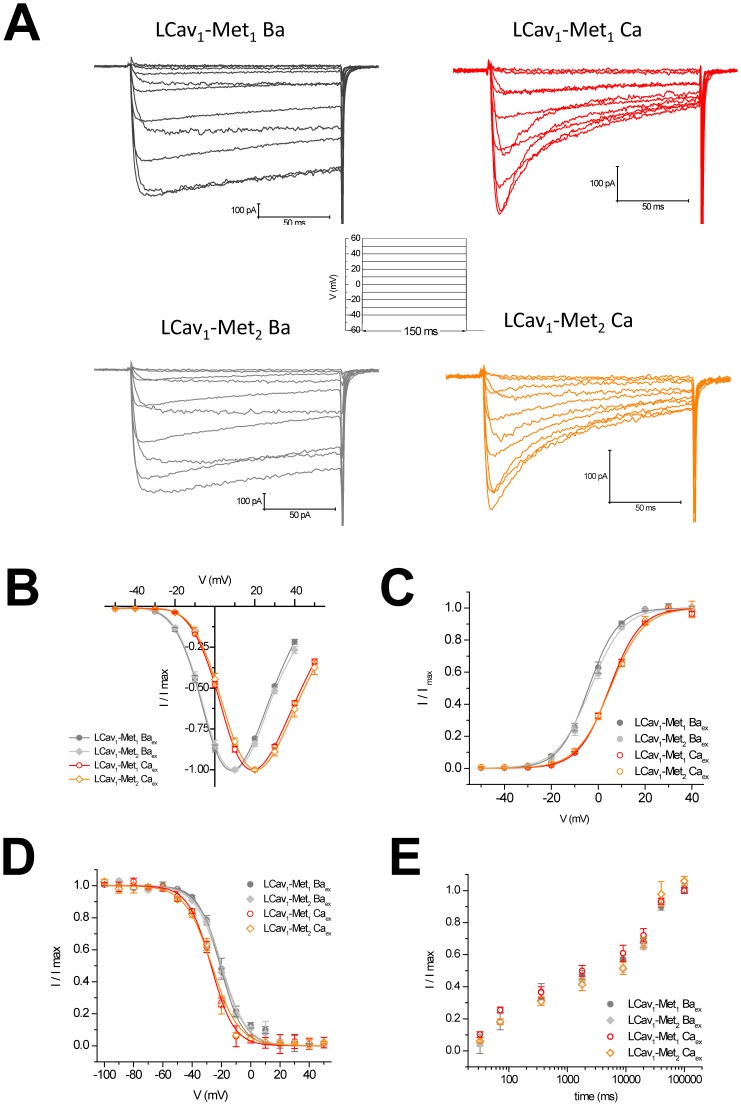
No major differences in biophysical properties between snail LCav1 channel containing a full-length N-terminus with NSCaTE translated from upstream methionine Met1 or truncated N-terminus missing NSCaTE generated from the downstream methionine Met2.LCav1-Met1 and LCav2-Met2 were transfected in HEK-293T cells alongside mammalian α2δ1 and β1b accessory subunits and recorded in 10 mM Barium (Ba) or Calcium (Ca) containing extracellular solution using patch clamp electrophysiology. Intracellular solution contained 9 mM EGTA. (A) Representative current traces generated from voltage steps (−40 mV to 60 mV in 10 mV steps) from a holding potential of −60 mV) illustrating the typical buffer resistant (9 mM EGTA) calcium-dependent inactivation when calcium is the charge carrier, leaving residual voltage-dependent inactivation when barium replaces calcium in the extracellular solution. (B) Normalized current-voltage relationships (n = 10), transformed and Boltzmann-fitted as activation curves in (C). (D) Steady-state availability curves (Baex: n = 10, Caex: n = 6), generated by measuring the fraction of maximal current generated after a 10 s sustained prepulse voltage from −100 to +50 mV in 10 mV steps). (E) Time of recovery from inactivation (n = 4) measured as the fraction of maximal current recovery after time delays, plotted on a log scale.